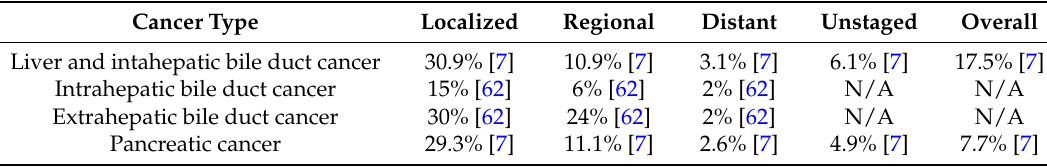
Table 1. Five-year survival rates for hepatobiliary and pancreatic (HBP) cancers.